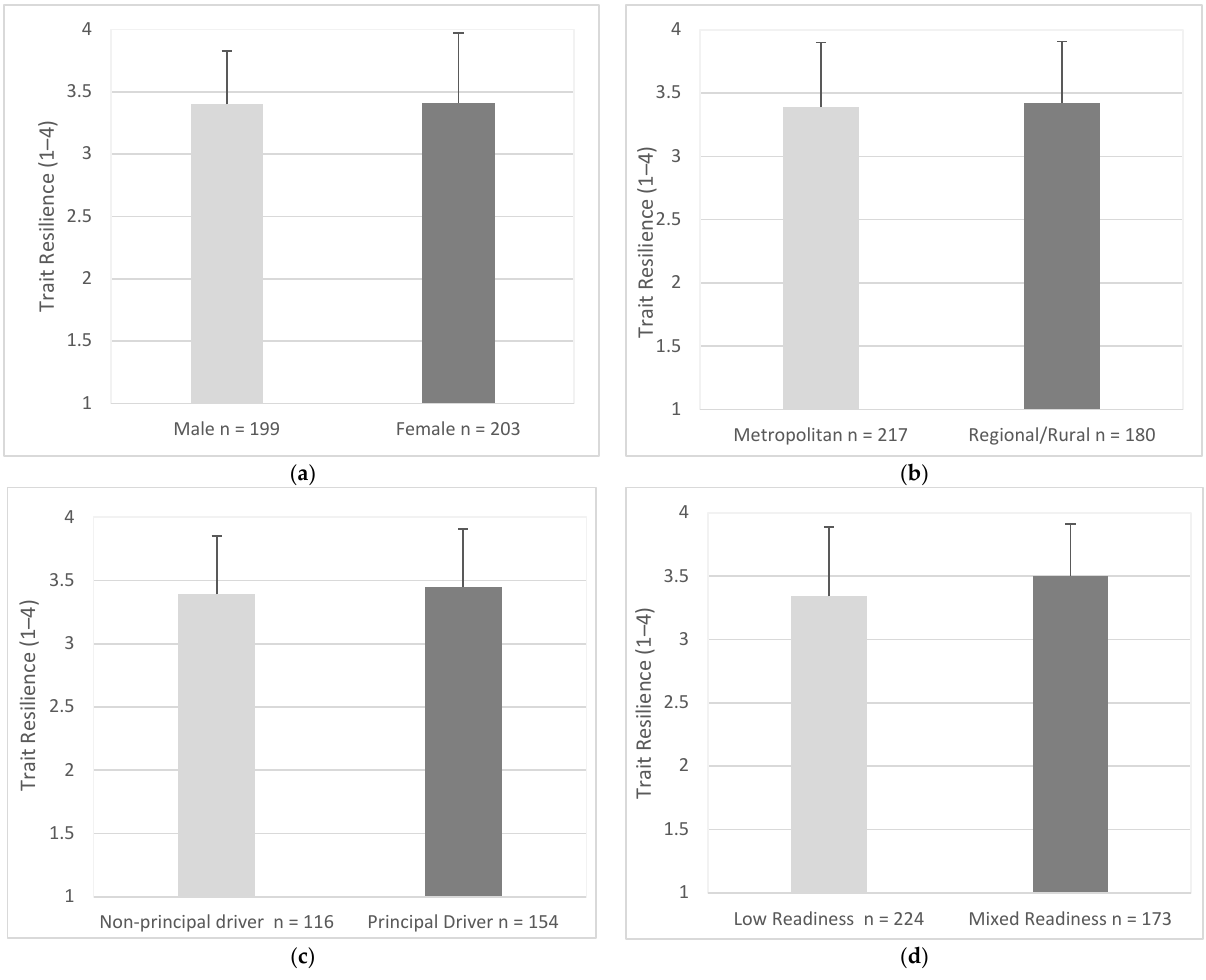
Figure 12. Trait Resilience as endorsed by participants in each group. Items were measured using responses of 1 (disagree) to 4 (strongly agree). ( a ) Gender, ( b ) Residential Area, ( c ) Driving Roles, ( d ) Readiness. Table 2. Spearman correlations between driving characteristics, readiness for mobility change and perception of driving